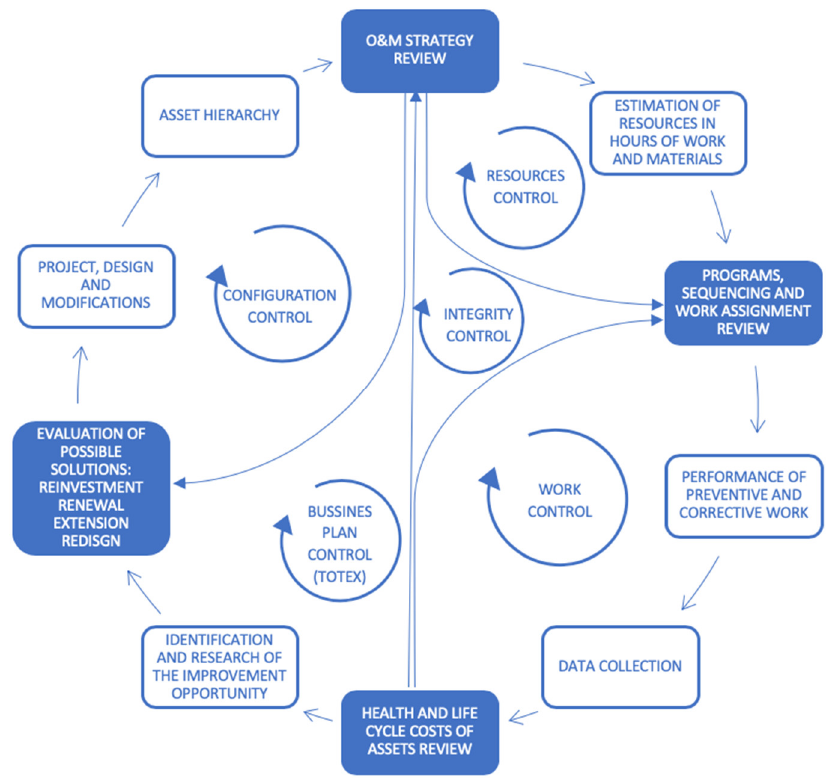
Figure 8. A perspective of Asset Management (AM) decisions and controls.